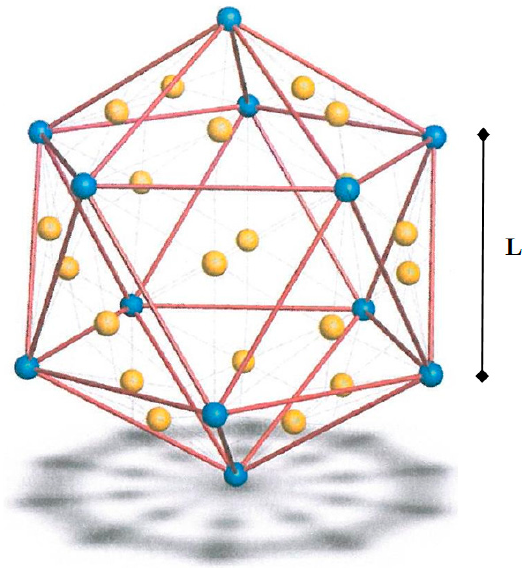
Figure 3. Second variation of the icosahedral model.